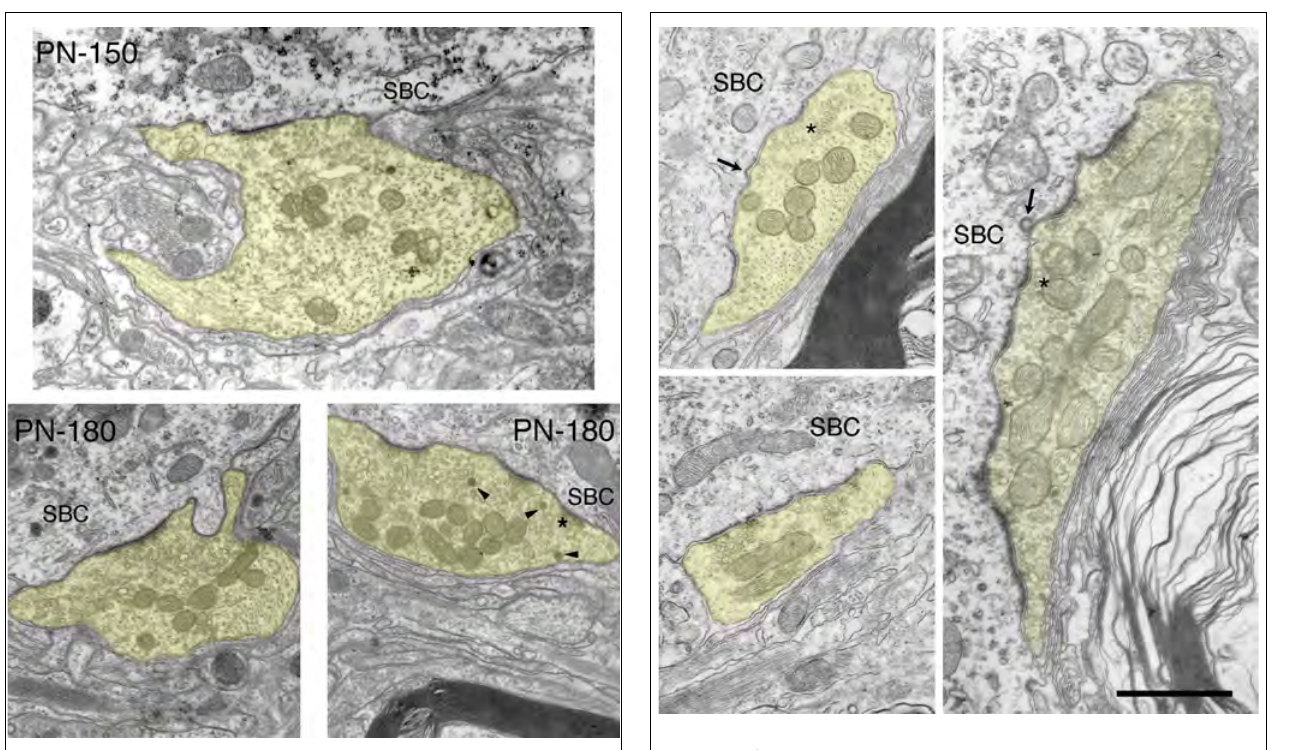
FIGURE 9 | Electron micrographs of endbulbs from 150-day and 180-day deaf white cats. The most prominent and stable morphological features are fl attening and lengthening of PSDs, accumulation of synaptic vesicles near the synapses, and increased mitochondrial volume fraction. Smaller, normal looking PSDs (*) are not uncommon in mature deaf animals but they are far outweighed by long fl at synapses. Occasionally large dense-core vesicles (arrowheads) can be seen. Scale bar equals 1 µm.